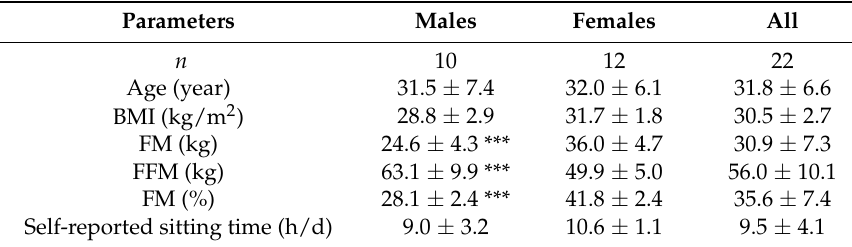
Table 1. Study participant’s anthropological characteristics and habitual sitting time. Parameters